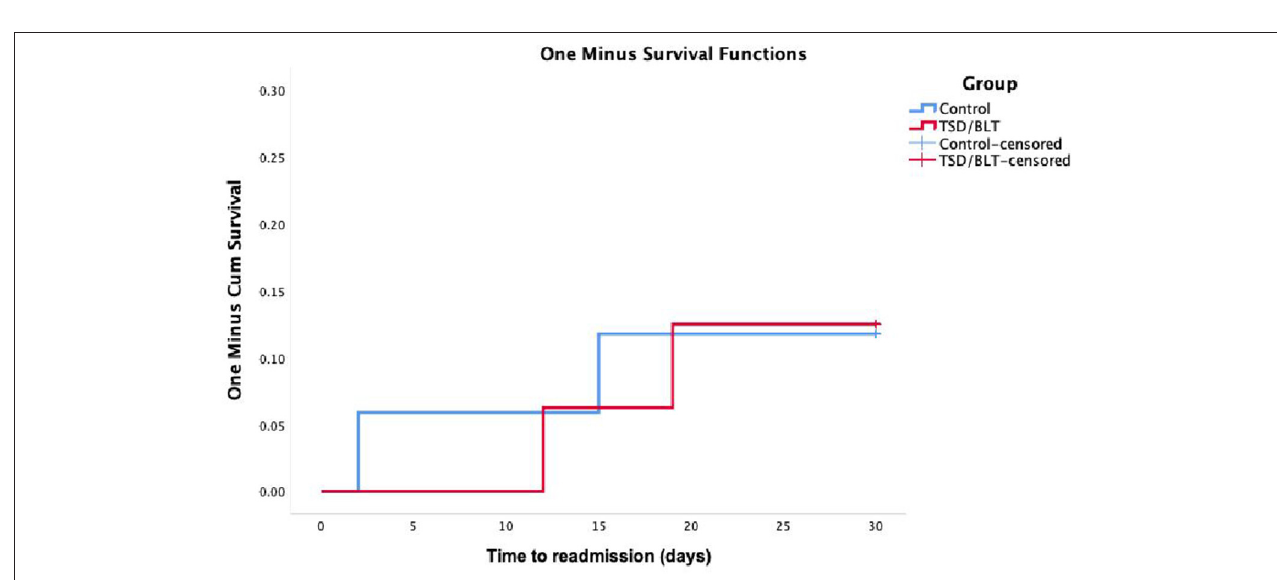
FIGURE 4 | Kaplan-Meier survival curve for time to psychiatric ward